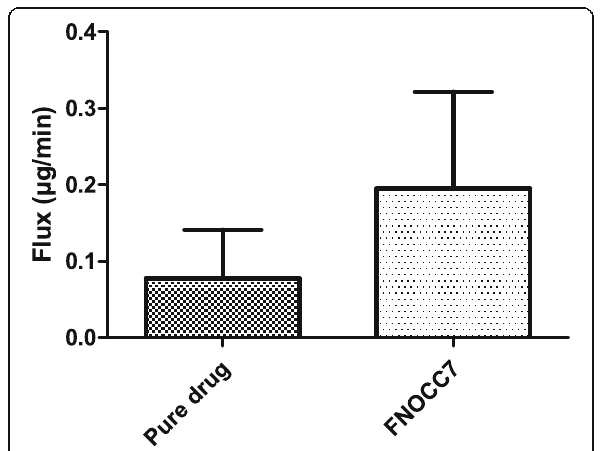
Fig. 8 Permeation flux of fenofibrate pure drug and fenofibrate co- crystal formulation (FNOCC7) in non-everted rat intestinal sac